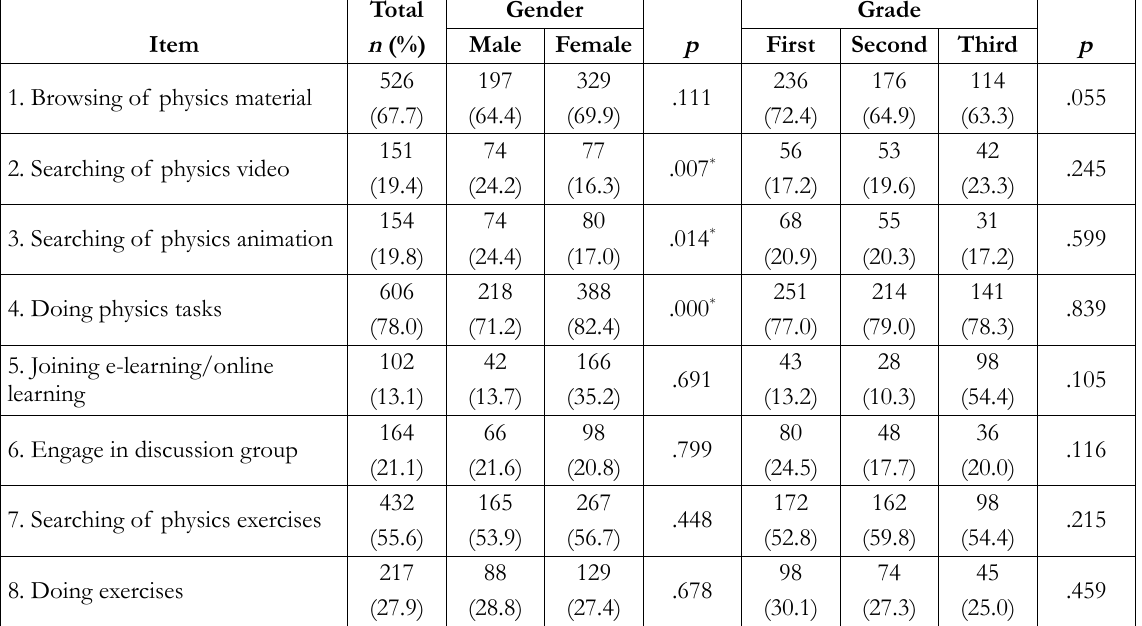
Table 4. Purpose of internet use by students related to learning